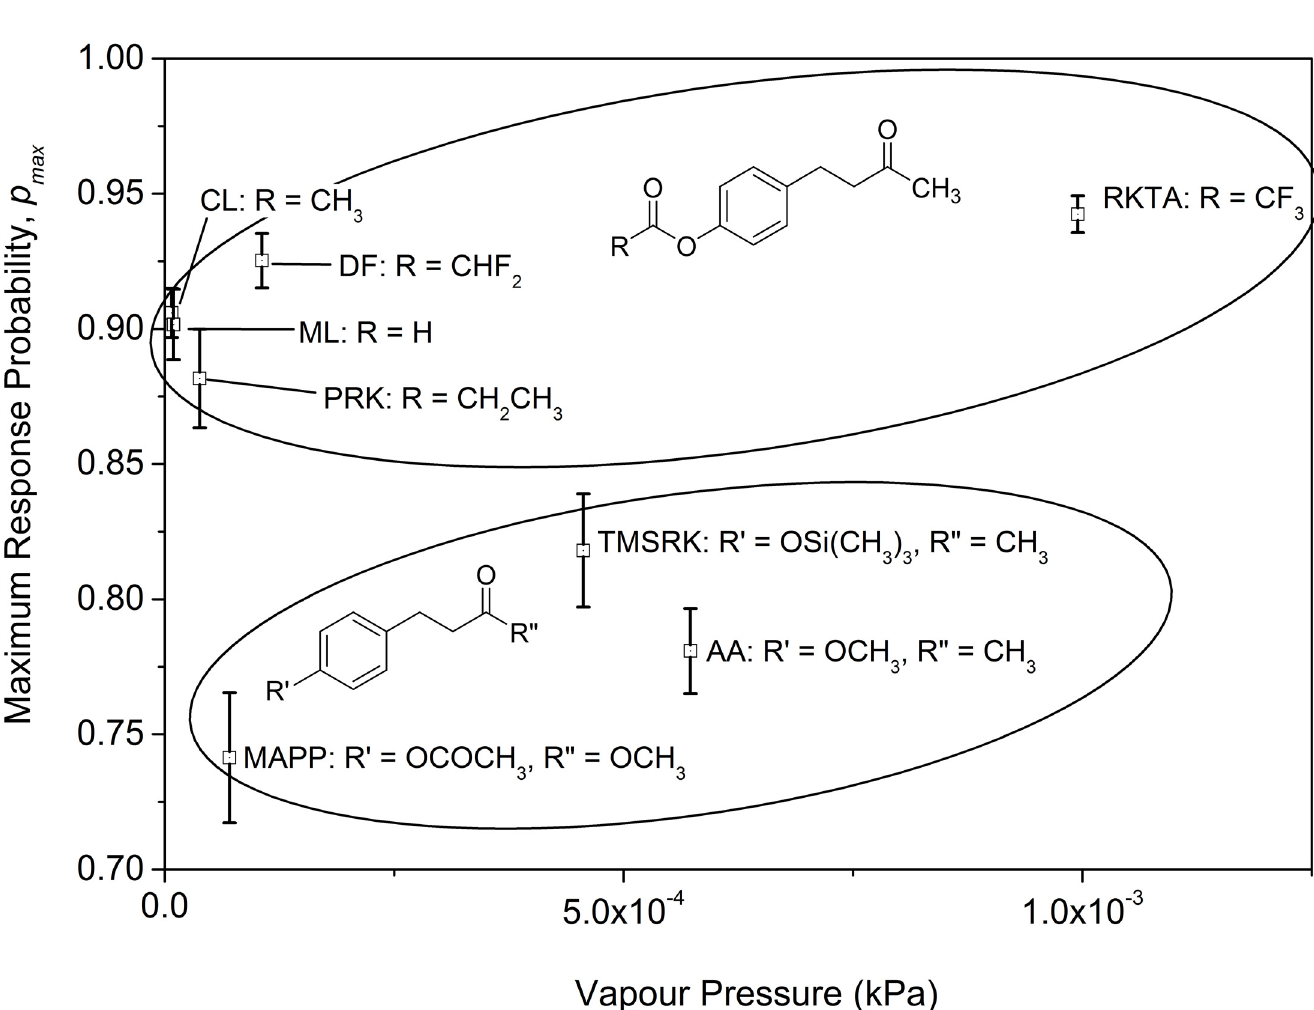
Fig 4. Maximum Response Probability as a Function of Vapour Pressure. CL: 4-(4-acetoxyphenyl)-2-butanone, DF: 4-(4-(2,2-difluoroacetoxy) phenyl)-2-butanone, RKTA: 4-(4-(2,2,2-trifluoroacetoxy)phenyl)-2-butanone, ML: 4-(4-formyloxyphenyl)-2-butanone, AA: 4-(4-methoxyphenyl)- 2-butanone, TMSRK: 4-(4-((trimethylsilyl)oxy)phenyl)-2-butanone, PRK: 4-(4-propionyloxyphenyl)-2-butanone, MAPP: methyl 3-(4-acetoxyphenyl)